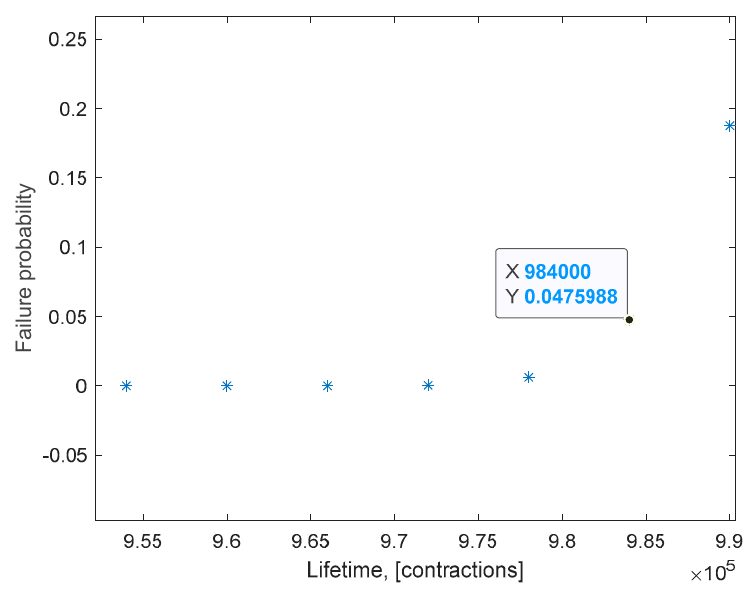
Figure 6. Failure probability at the beginning of each inspection interval.